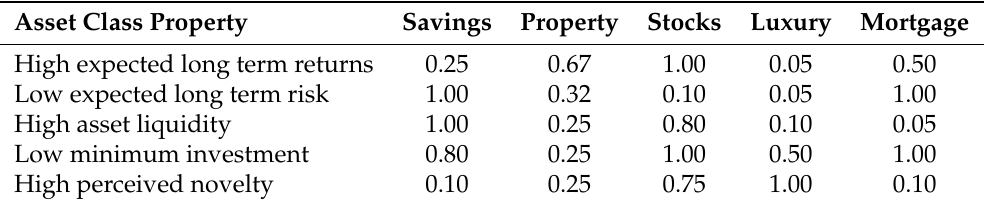
Table 1. A matrix P rating the performance of each asset class with respect to a set of desirable properties. Values are in range [ 0,1 ] and represent a relative low to high score in each of the